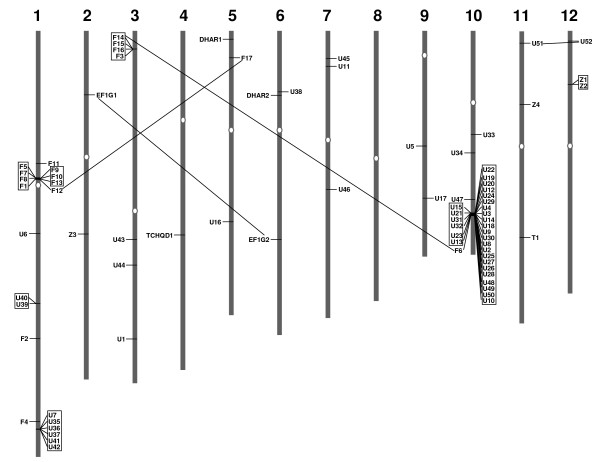
Chromosomal distribution of rice GST genes. The chromosome number is indicated at the top of each chromosome. GST genes localized on duplicated chromosomal segments are connected by lines. The genes labeled on left side are oriented from bottom to top and those on right side are oriented from top to bottom on rice chromosomes. Six clusters (three on chromosome 1 and one each on chromosome 1, 10 and 12) of tandemly arranged GST genes are indicated in boxes. Exact position of each GST gene on rice chromosome pseudomolecules is given in Additional file 1.